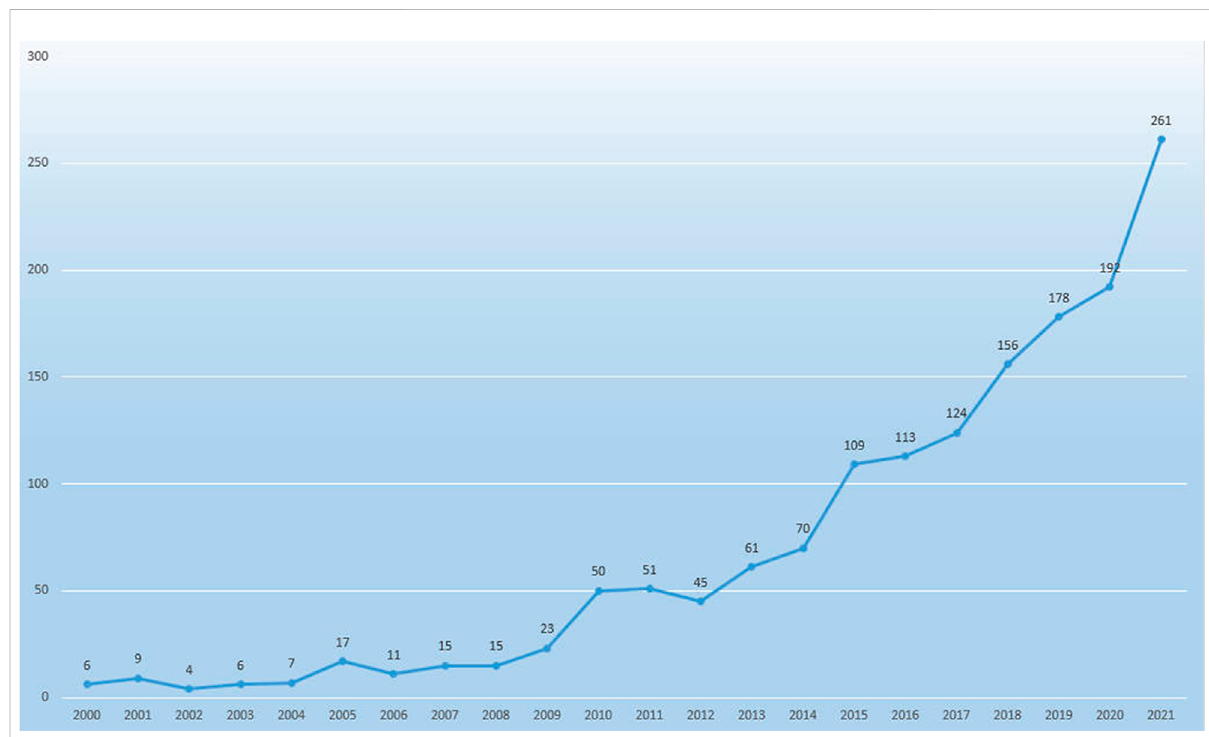
FIGURE 2 Annual number of the published publication in biomaterials research in osteogenesis from 2000 to 2021.